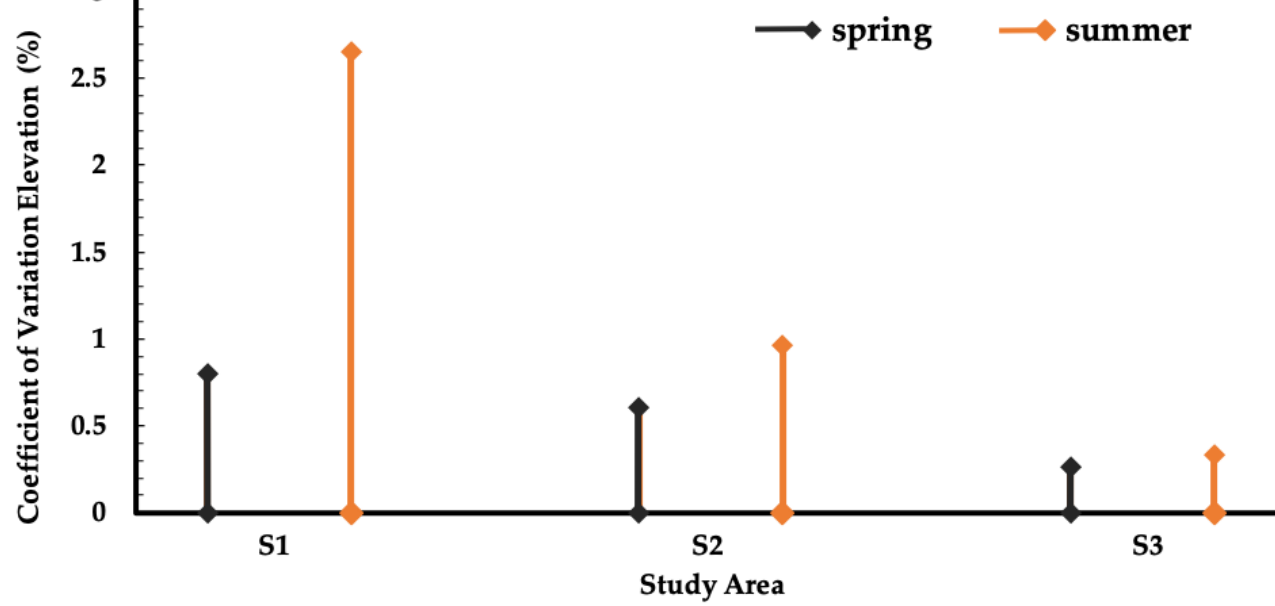
Figure 9. The average of the maximum and minimum values of surface roughness in the summer (orange color)/spring (black color) season for each study area. The horizontal axis represents the index of the study area, and the vertical axis shows the surface roughness. The minimum values are all close to zero, but the maximum values differ among regions and seasons.